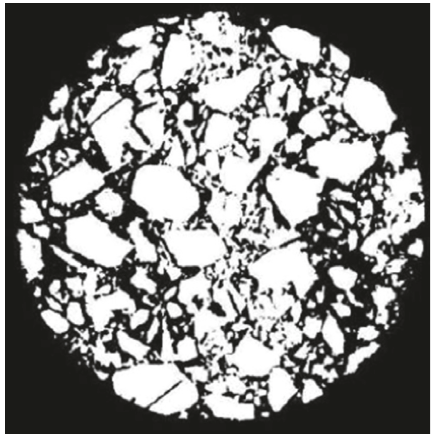
Figure 6: Fuzzy c-mean method.